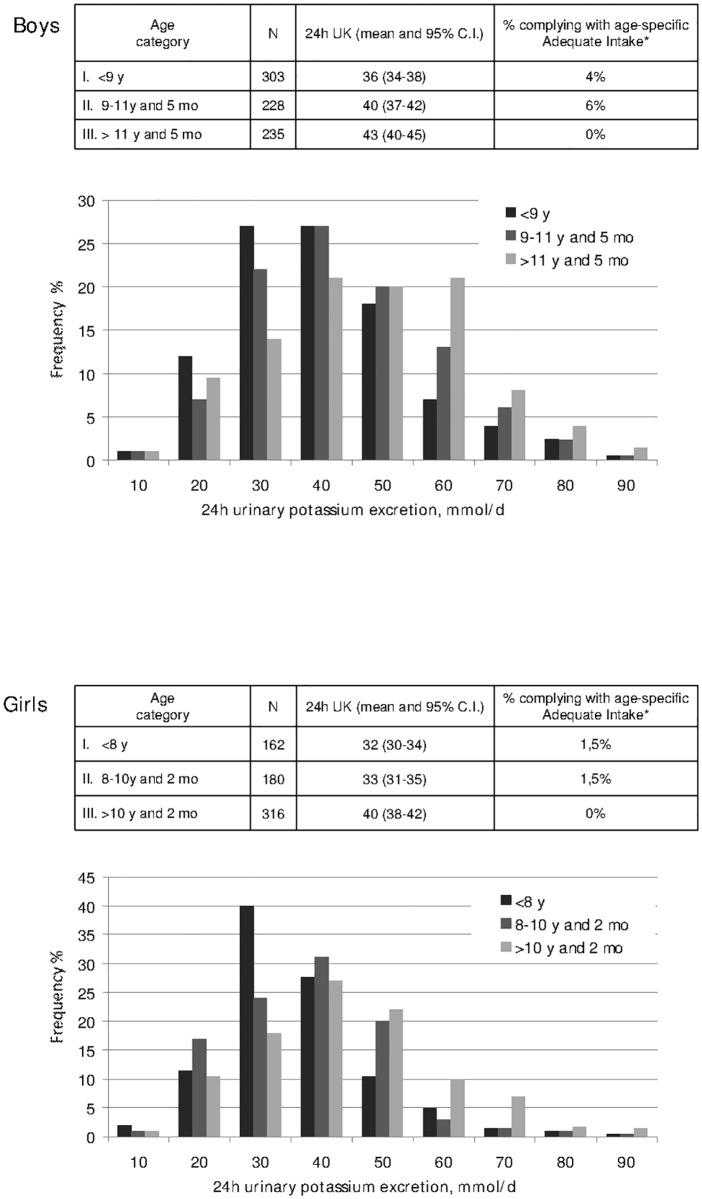
Gender-specific frequency distribution of 24-hour urinary potassium excretion in boys (A) and girls (B) (data from 10 Italian regions, age 6–18 years, MINISAL-GIRCSI Program).The insets in the figures report the mean values of electrolyte excretion by development stage and denote the percentage of individuals complying with the respective adequate intakes as established by the Italian Society for Human Nutrition and the Institute for Food Research and Nutrition (ref. 18). *Data based on the assumption that 24h urinary sodium excretion provides an estimate of daily potassium intake.